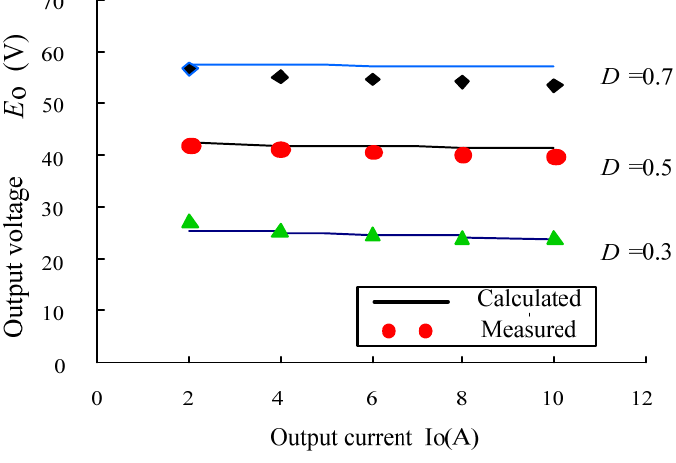
Figure 11. Calculated and measured output voltages versus load current.